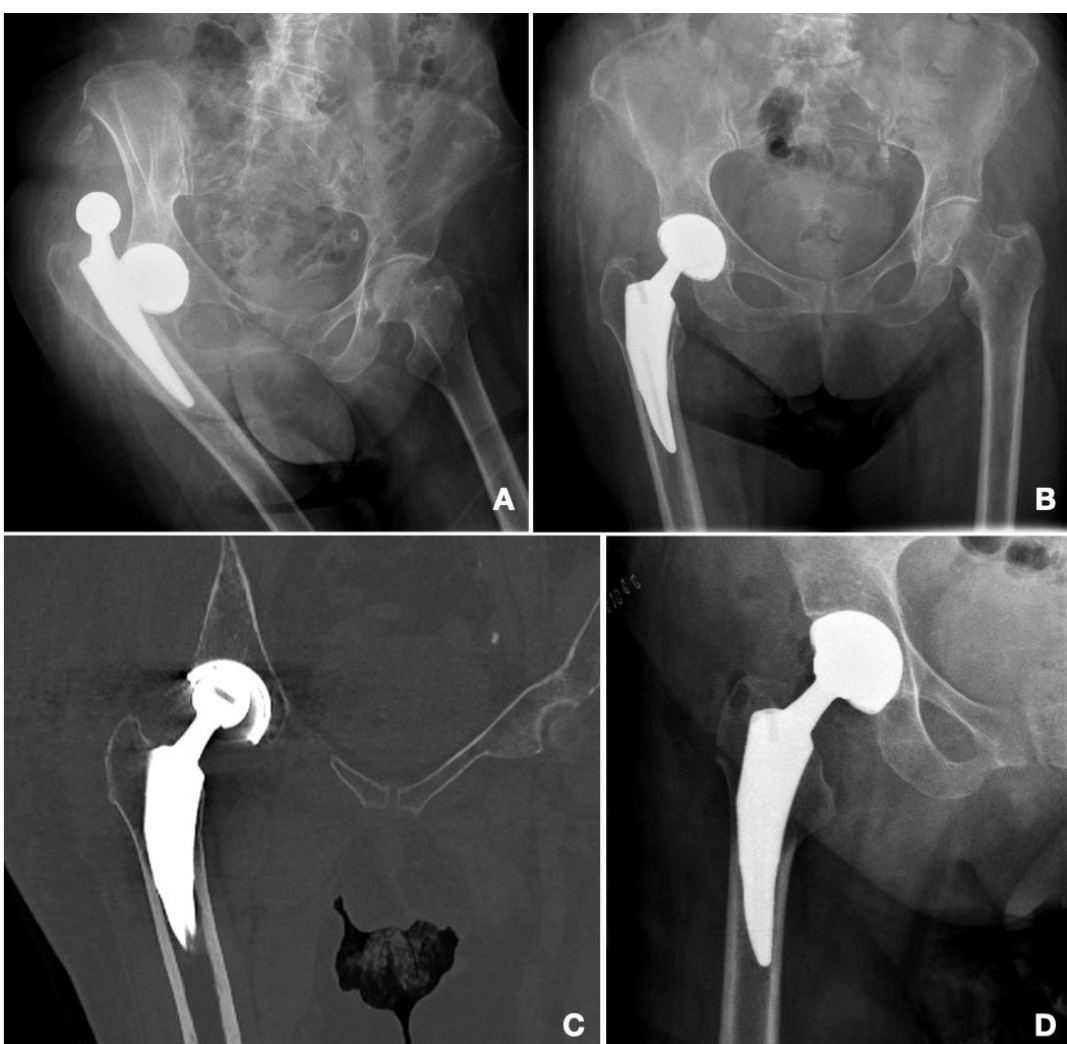
Figure 2. Case number 7. Intraprosthetic dislocation. ( A ) Emergency department X-ray. ( B ) Control X-ray after closed reduction maneuvers. ( C ) CT Scan after closed reduction maneuvers. Note the displacement of the head, eccentric within the acetabular cup. ( D ) Post-op control after revision surgery.